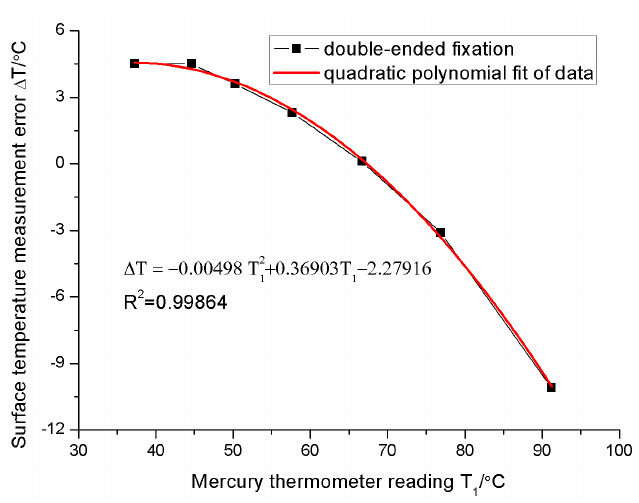
Figure 11. Surface temperature measurement errors of sensor with the double-ended fixation.